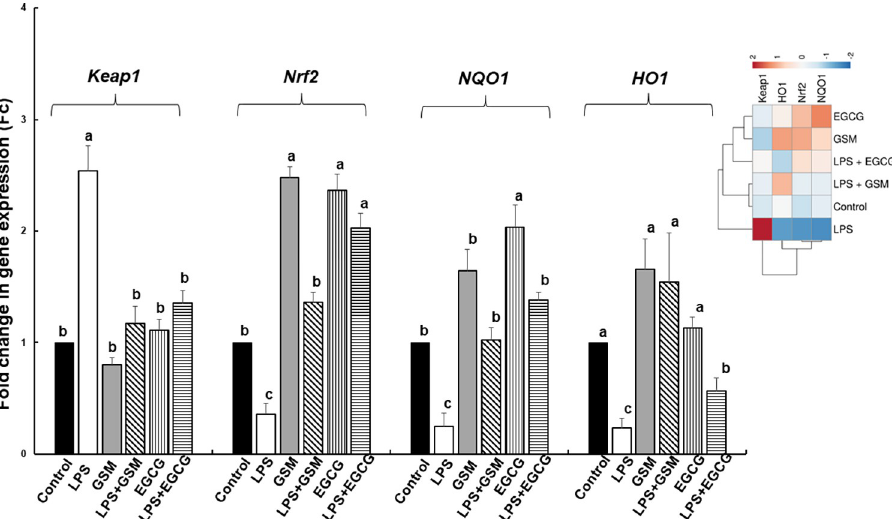
Fig 3. The effects of GSM on the expression of genes coding for Keap1/Nrf2 signalling pathway in IPEC-1 cells. IPEC-1 cells were incubated with the following treatments: Control = untreated cells; LPS = cells treated with LPS